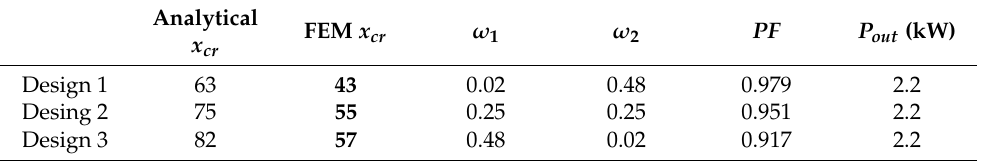
Table 8. Critical inertia factors, lifetimes, and scores of DE